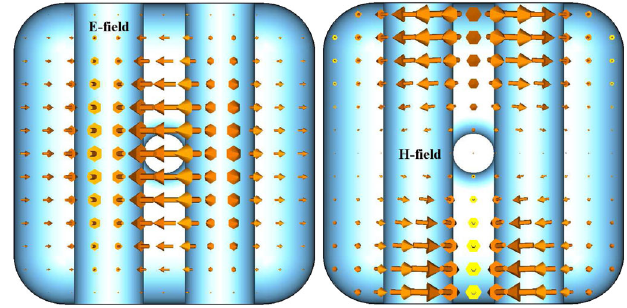
~E; ~H Þ FIG. 3. Electromagnetic field ð distribution of the super- conducting cavity (see Fig. 2) in the xy plane. The electric field is strongly concentrated over the central region due to the dominant capacitive effect; however, the magnetic field becomes predominant near the top and bottom where the electrodes are electrically shorted with the corresponding perfectly conducting